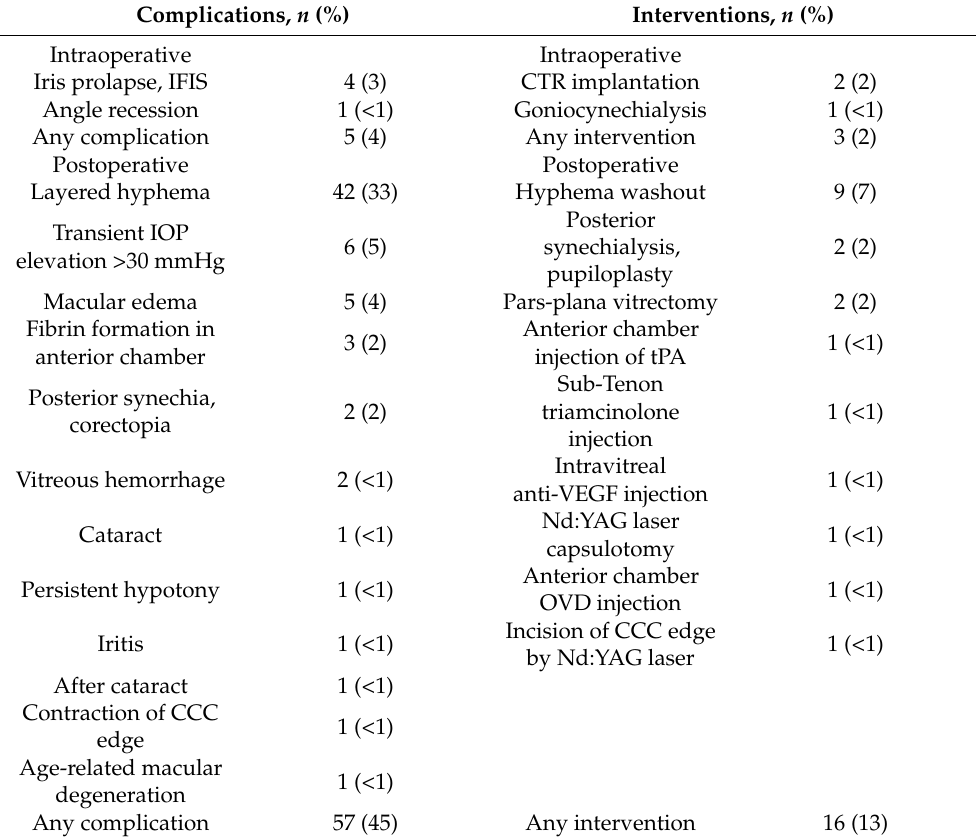
Table 3. Intraoperative and postoperative complications and interventions.